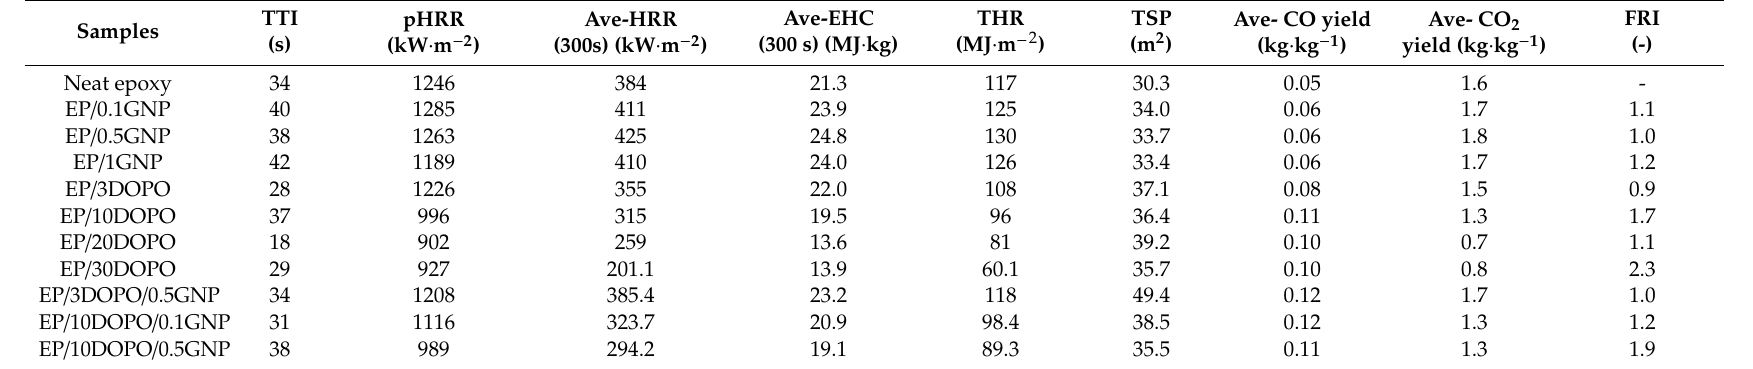
Table 3. Parameters from cone calorimetry analysis including TTI, pHRR, ave-HRR, ave-EHC THR, TSP, ave-CO yield and ave-CO 2